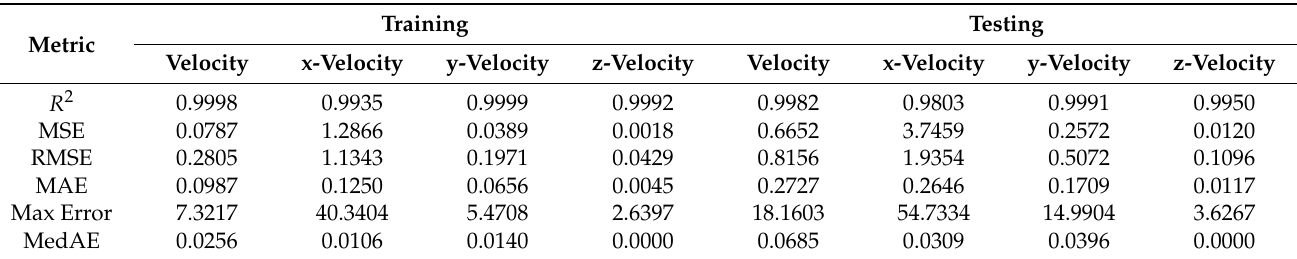
Table 1. Performance of the RFR models on training and testing data.